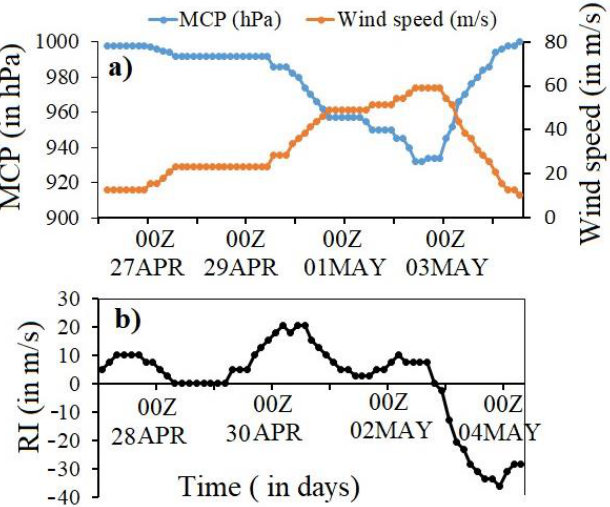
Figure 2. ( a ) CSLP and MSW of ESCS Fani 2019 during its life-period and ( b ) rapid intensification (RI; wind speed more than 15.46 m/s within 24 h) observed from IMD best-fit track.